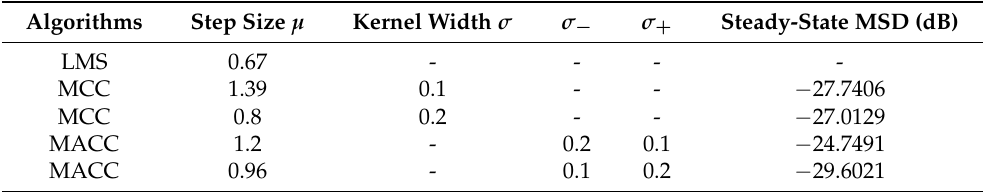
Table 4. Parameters and steady-state MSD of MCC and MACC in simulation 3.